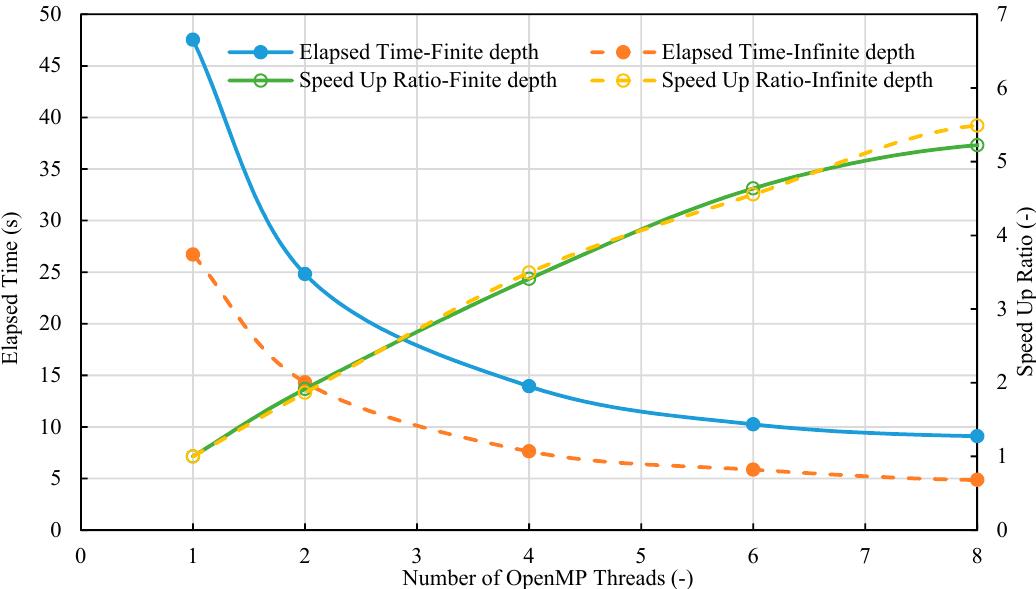
Figure 13. Computation efficiency of the HAMS solver for each wave frequency against the number of threads in finite and infinite depth, respectively.